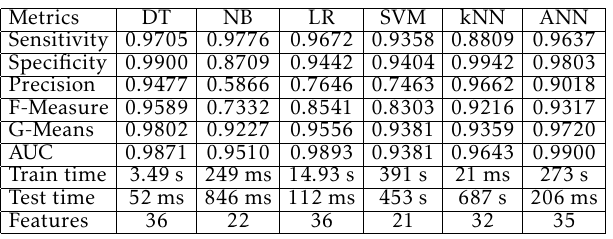
Table 20. Results of using GR-BFE on RECONNAISSANCE. Metrics